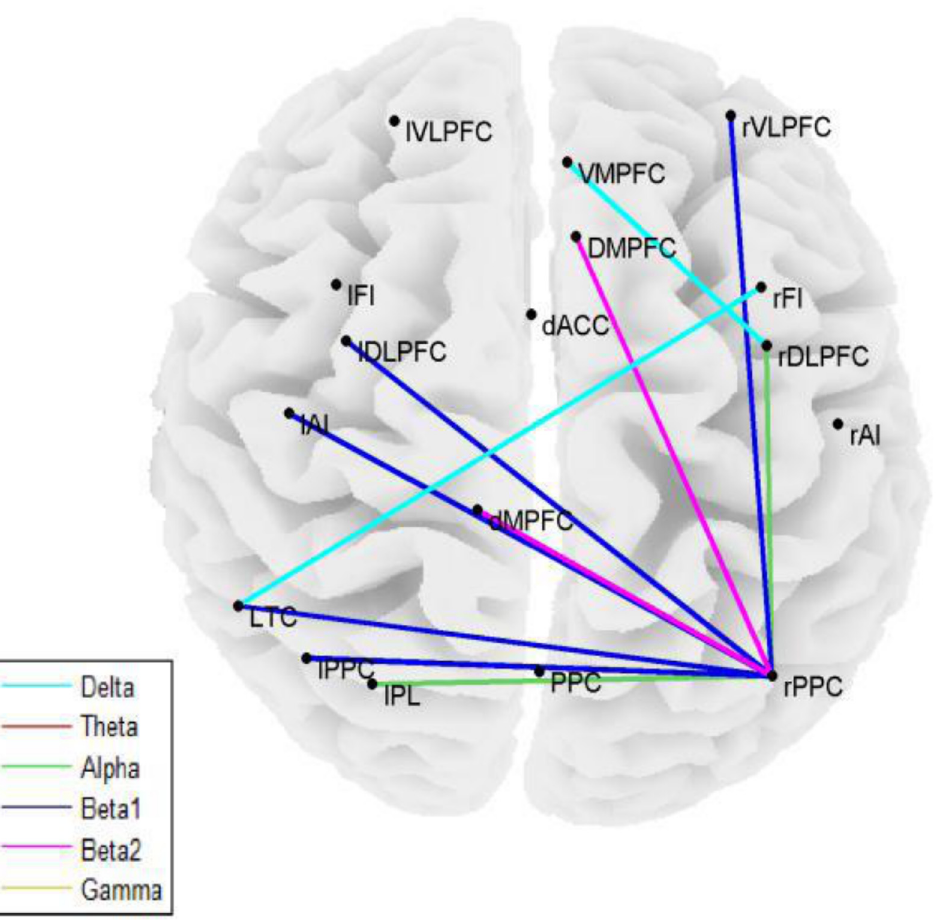
Fig 3. Nodal connectivity. Statistically significant differences in nodal connectivity (Directed Transfer Function) between patients and controls in various frequency